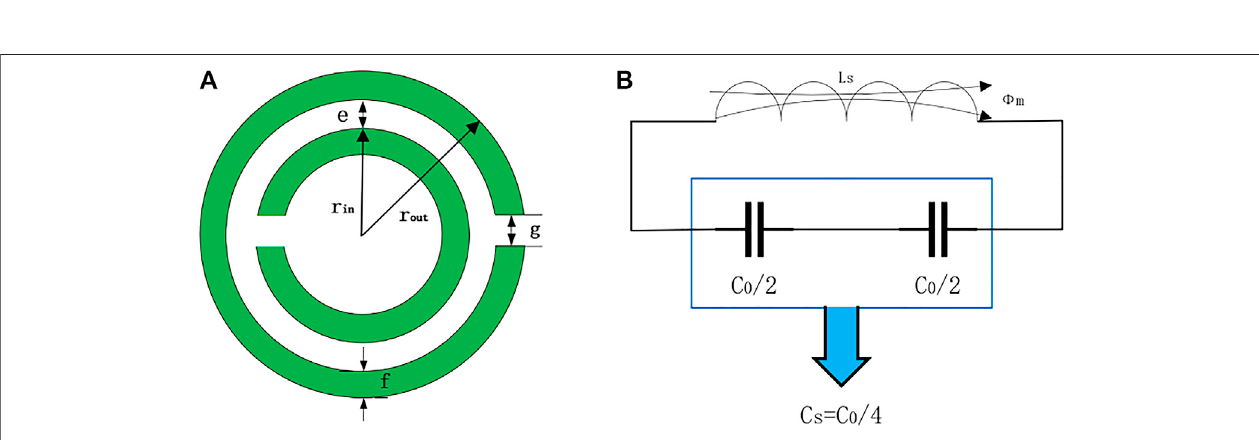
FIGURE 2 | (A) The structure of SRR, (B) the equivalent circuit diagram of the SRR structure.